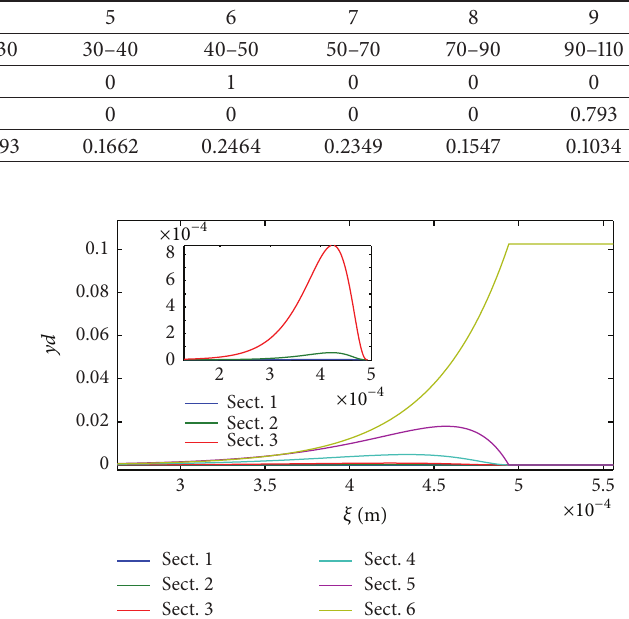
Figure 7: Influence of the vaporization coefficient in determining the flame velocity of laminar spray flames as function of the initial liquid fuel load, monosectional spray.